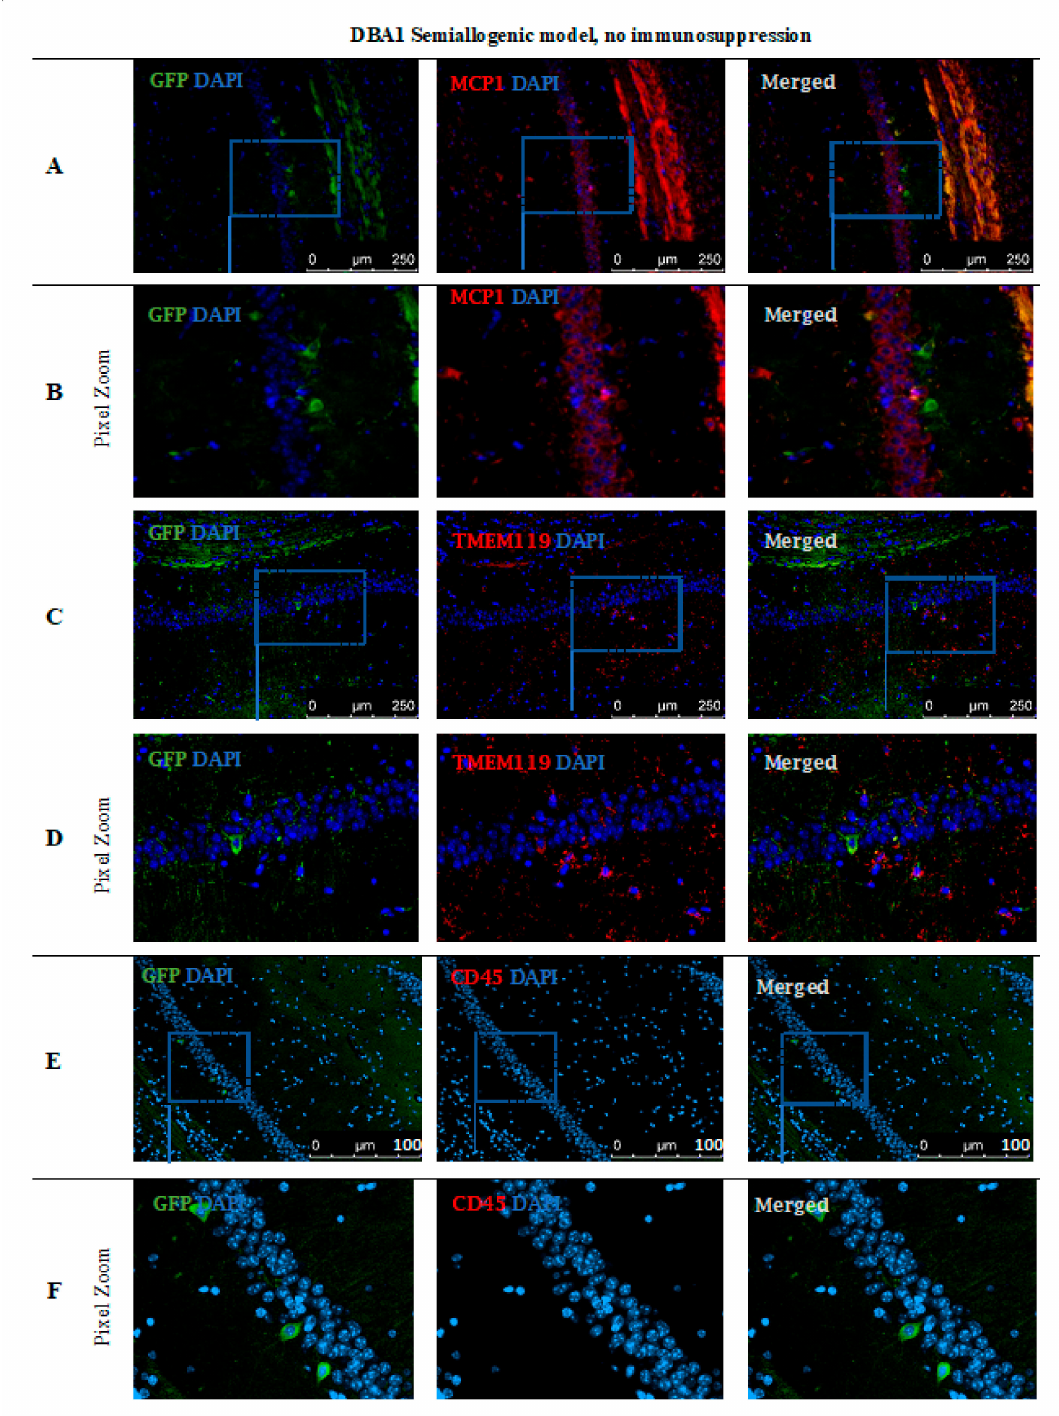
Figure 10. Post-mortem evaluation of GRPs’ graft localization in DBA1 semiallogenic model without immunosuppression applied: Immunohistochemical staining in the brain of DBA1 (semiallogenic) mice after 140 days of observation in a group with no immunosuppression applied. The staining revealed murine GRP GFP+ cells residing in the hippocampus, mostly in regio superior. Grafted cells were present close to MCP-1+ immune cells ( A , B ), as well as microglial cells (TMEM119+) ( C , D ). No CD45+ cells were visible in the adjacent tissues ( E , F ). Abbreviations: GFP-green fluorescent protein; GRP-glial-restricted progenitor